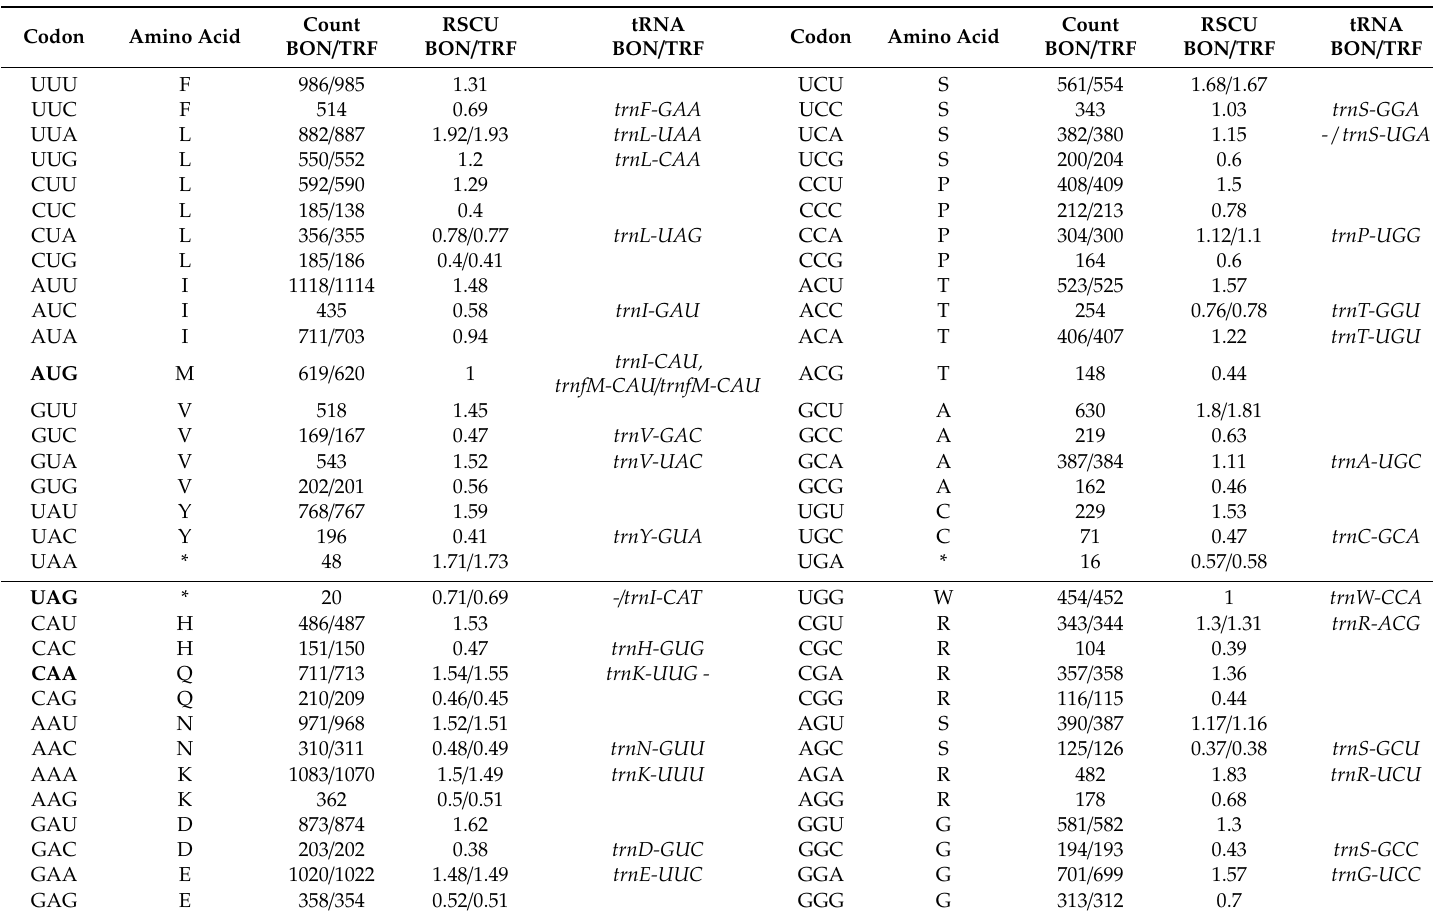
Table 2. Codon usage and codon–anticodon recognition pattern for tRNA in R. boninensis and R. trifidus cp genome. Species abbreviations, BON and TRF, represent R. boninensis and R. trifidus ,